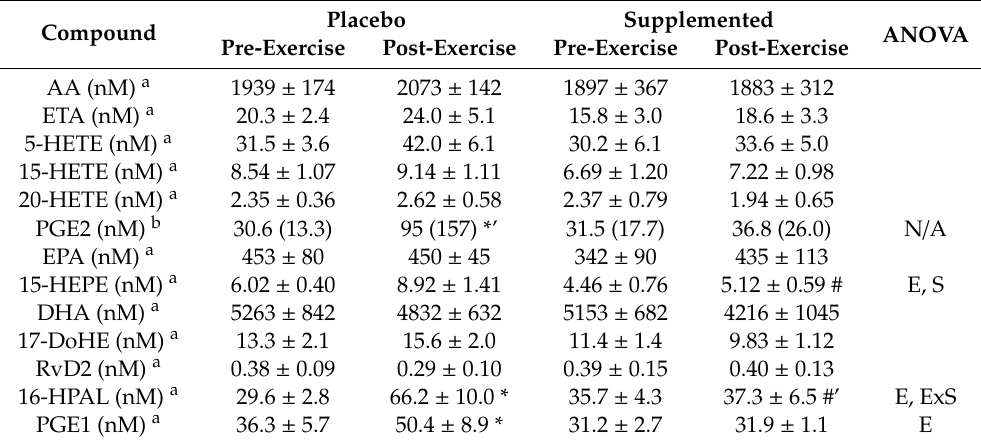
Placebo Supplemented